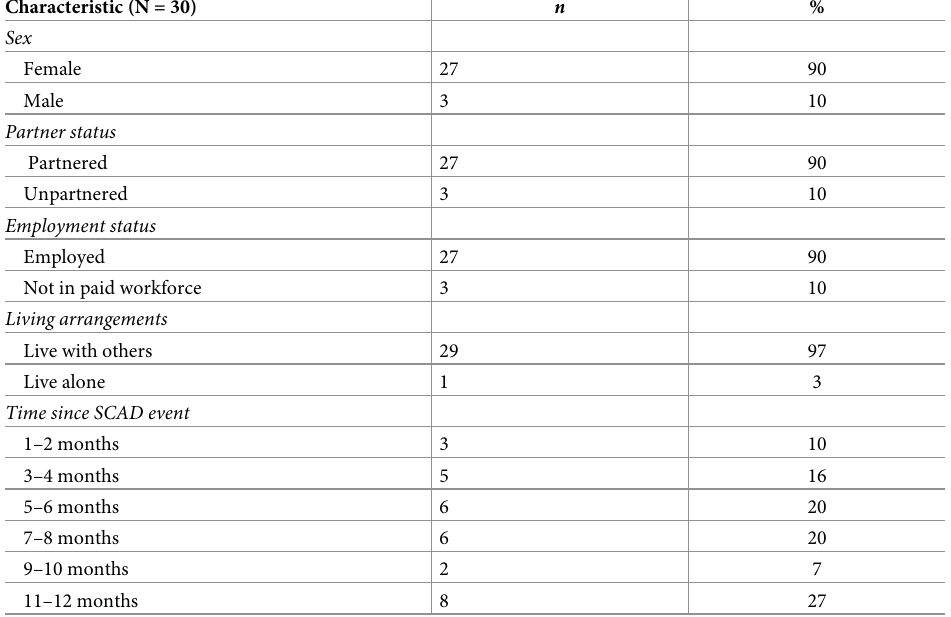
Table 1. Participant